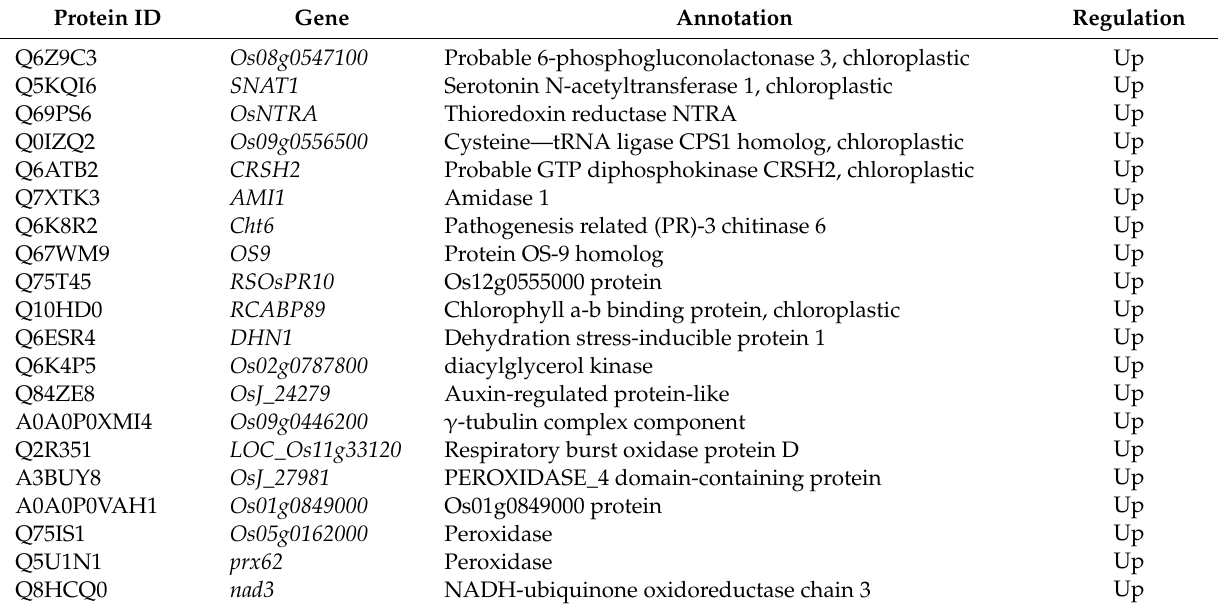
Table 3. Important di ff erentially expressed proteins related to photosynthesis, response to stimulus biotic, and abiotic